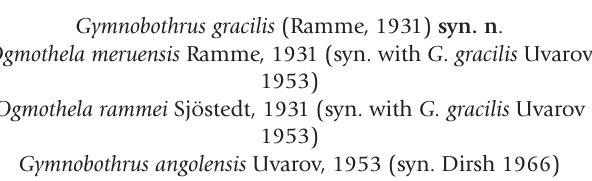
Description. —See key. Full treatment in the brachypterous species group section (pp. 86